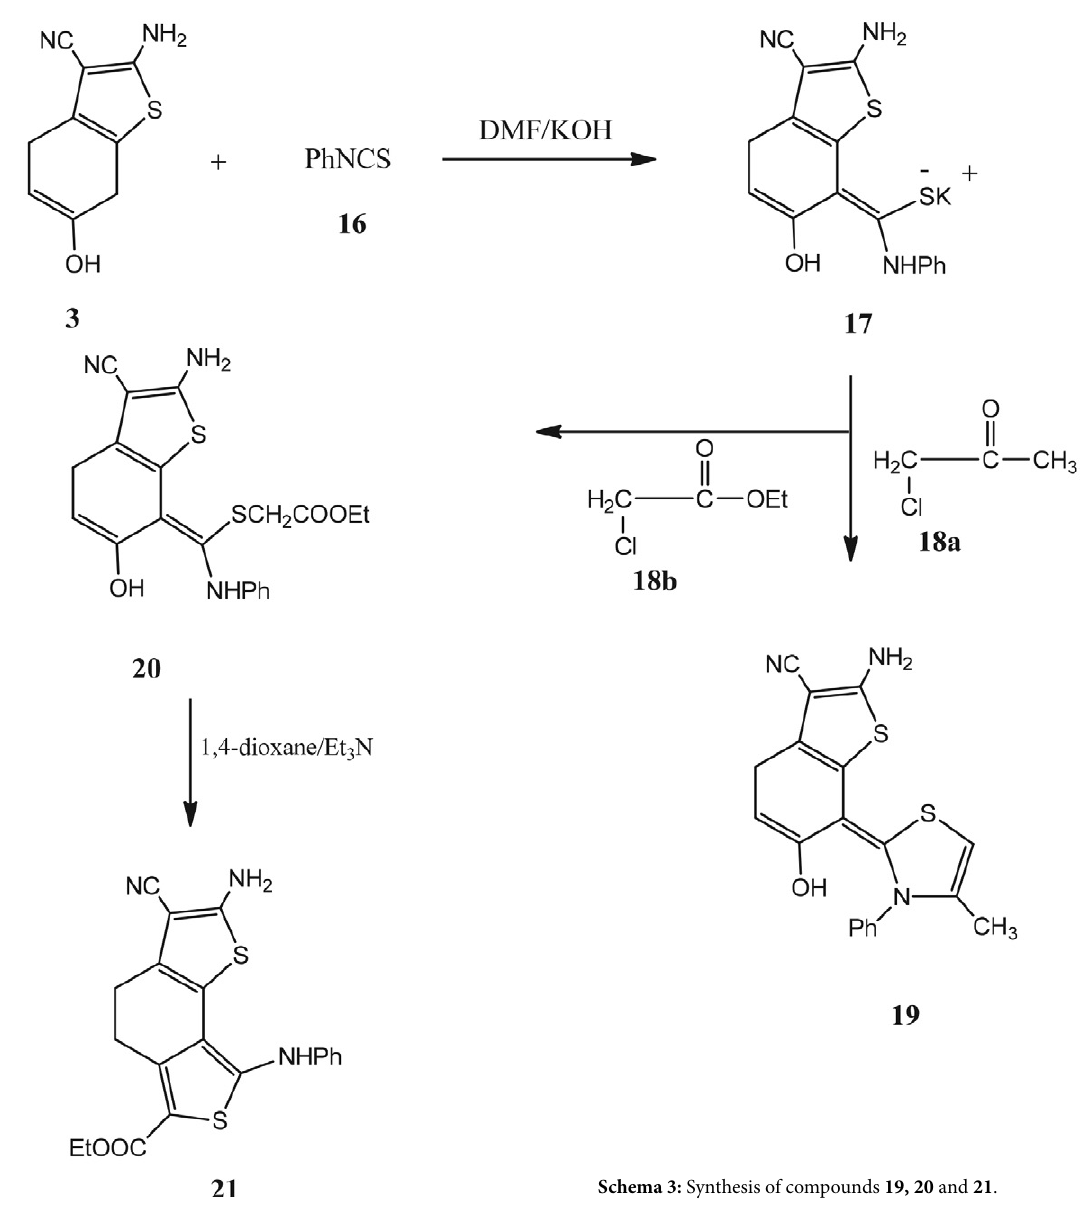
Schema 3: Synthesis of compounds 19, 20 and 21